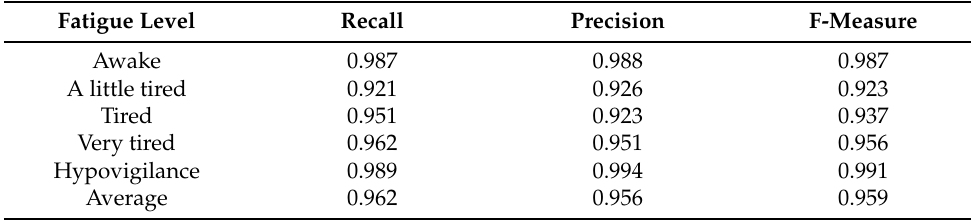
Table 4. Evaluation of the HyMobLSTM model using DEAP